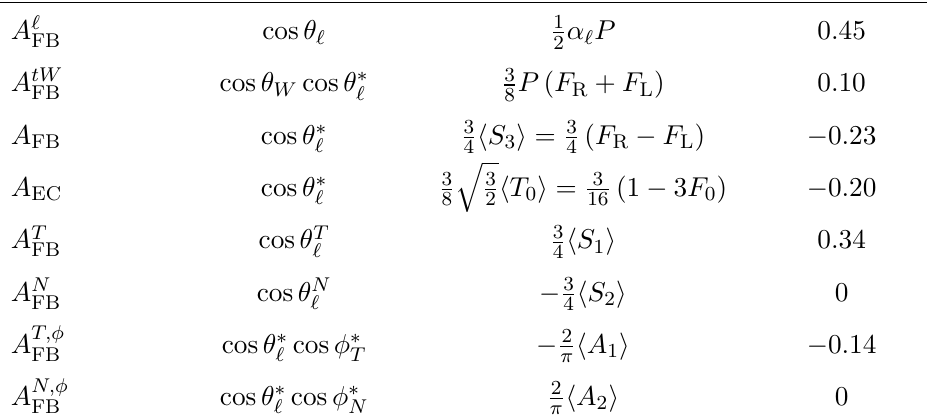
Table 1. Asymmetries with their associated angular observables and their relation to the top-quark polarisation and W -boson spin observables. The values predicted by the Standard Model are also given. They are calculated using the predictions at NLO in QCD for P and (cid:11) ‘ , the predictions at NNLO for the helicity fractions, and the predictions at LO for in these values are all lower than 0.01. They are estimated from the uncertainties in the top-quark, b -quark and W -boson masses, added in quadrature, including the uncertainty in (cid:11) s and an estimate of the higher-order e(cid:11)ects for the asymmetries related to the W -boson spin